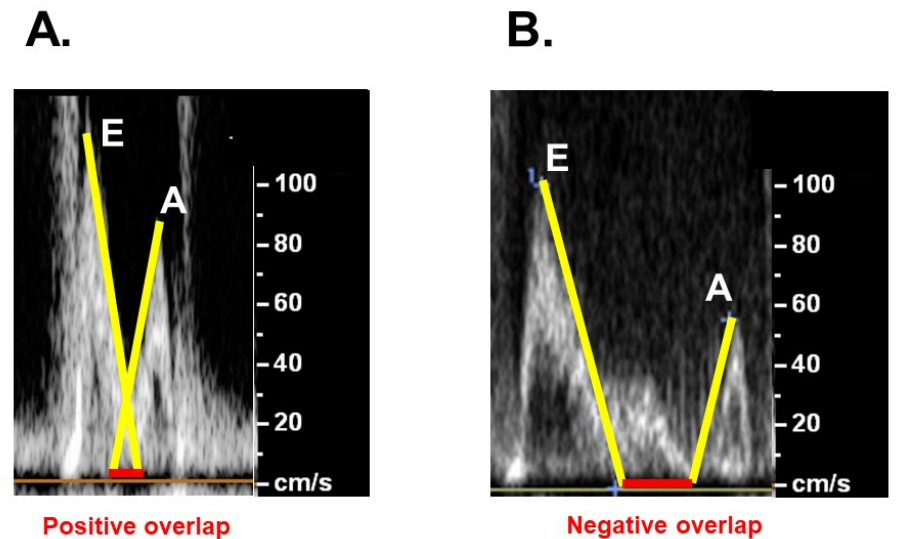
Figure 5. Trans-mitral inflow velocity focusing on the overlap between E-wave and A-wave using Doppler echocardiography on admission ( A ) and following heart rate modulation therapy using ivabradine ( B ). The two waves were overlapped in ( A ) and completely apart in ( B ).